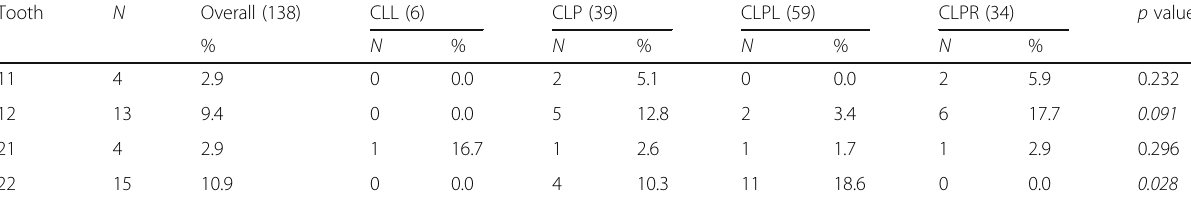
Table 5 Microdontia and cleft type by tooth in a total of 138 cleft patients Tooth